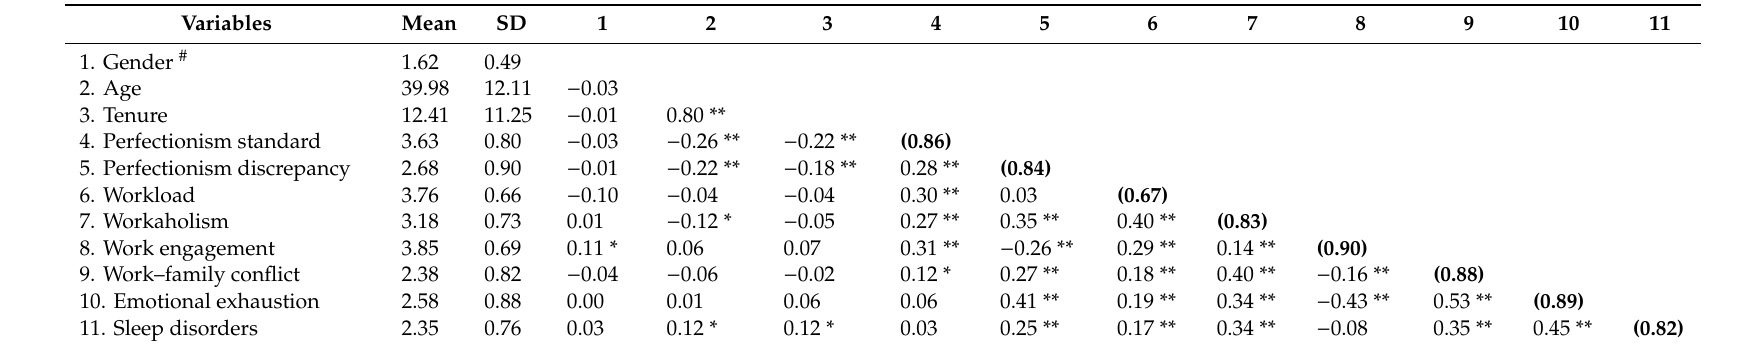
Table 1. Descriptions, inter-correlations, and reliabilities of the study